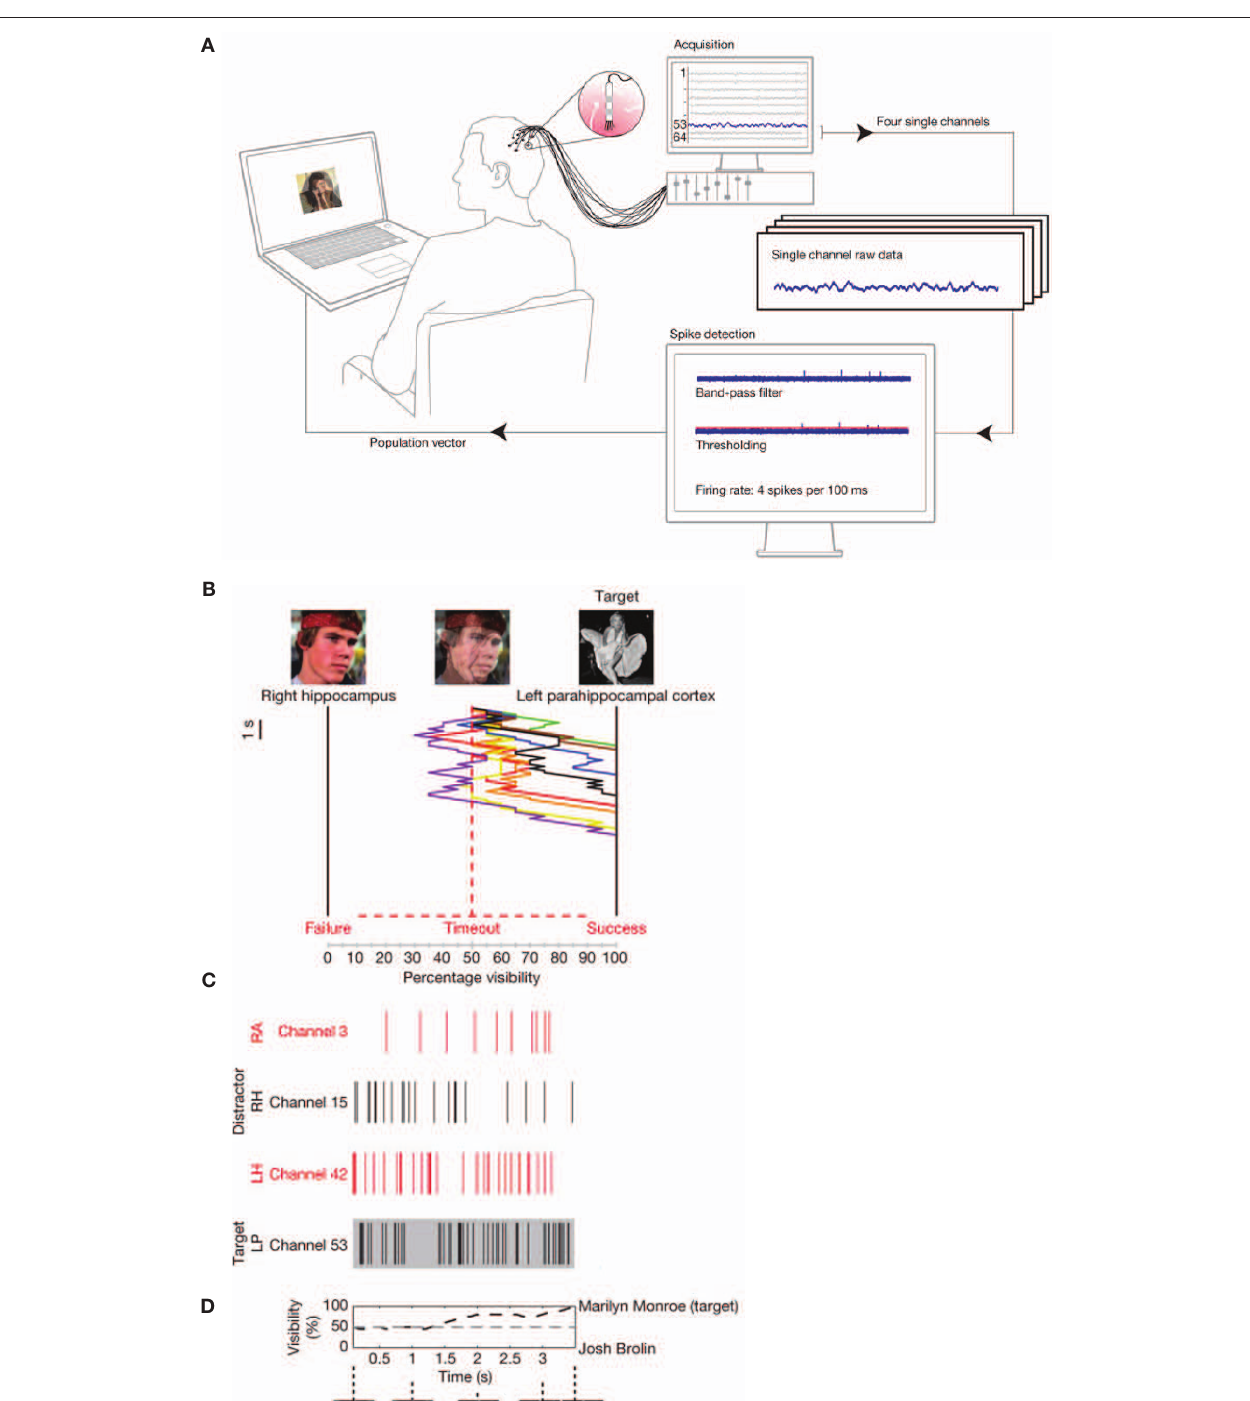
of the persons (e.g., Monroe). If the neurons coding for Monroe (C) fired stronger, the Monroe face was made more visible by the control loop. The example in (B) shows eight trials in which the subject was able to make the Monroe picture visible by voluntarily controlling the firing of the temporal lobe neurons. (D) The visibility of the target photo averaged over several trials. Reproduced with permission from Cerf et